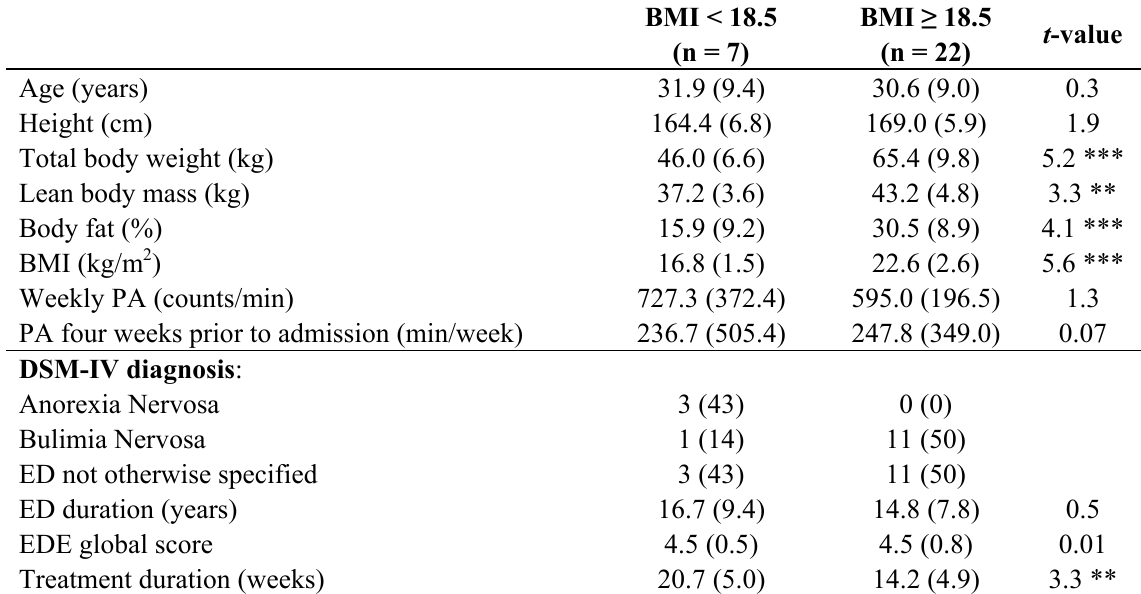
Table 1. Descriptive data. Values are shown in mean (SD) or n